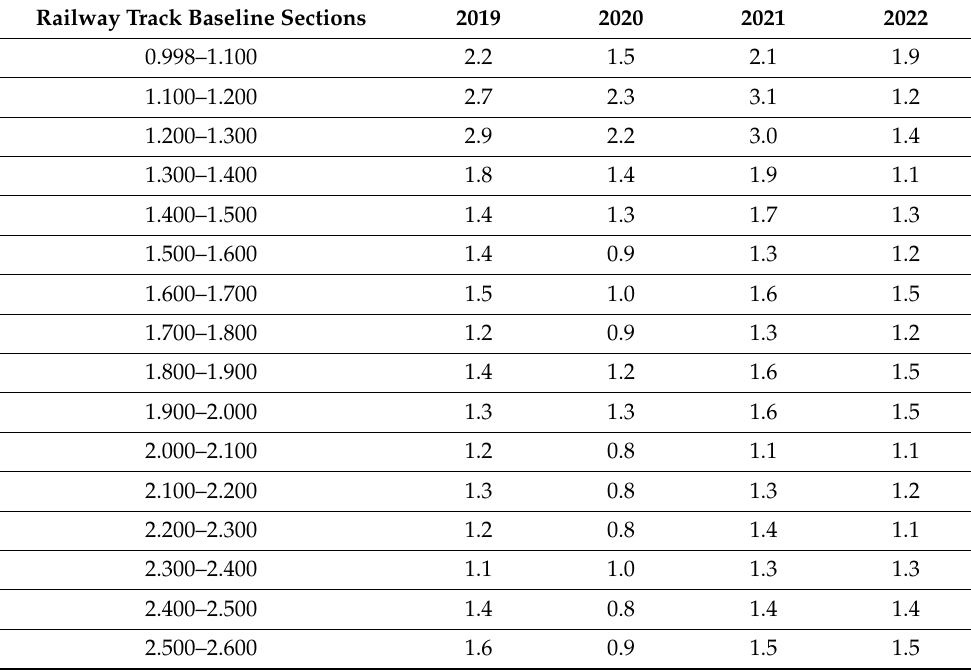
Table A1. Estimates of the railway track condition—absolute J , object Nos. R 143_1_1 and R 143_1_2. Railway Track Baseline Sections